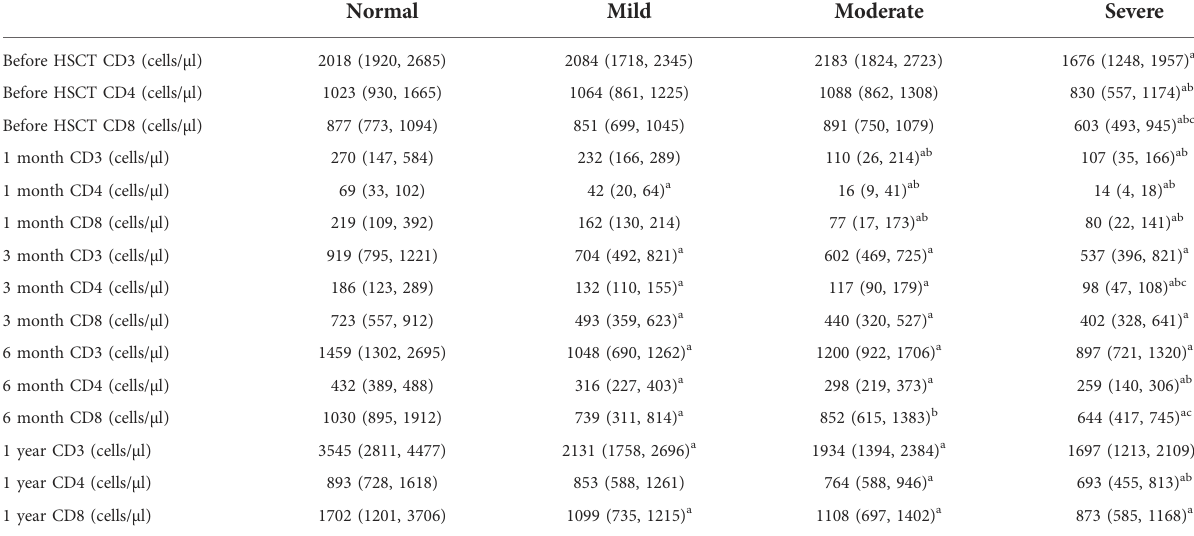
TABLE 2 Comparison of T-lymphocyte subsets between groups before and after